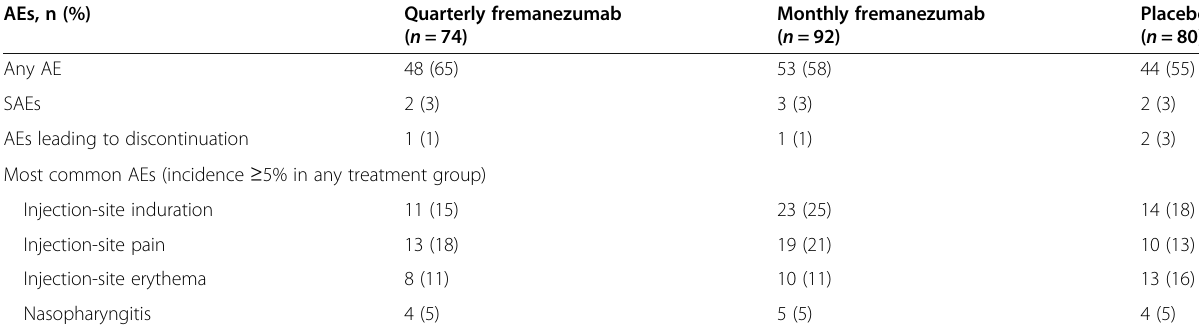
Table 2 Overall AEs in participants ≥ 60 years of age with ≥ 5% incidence in any treatment group